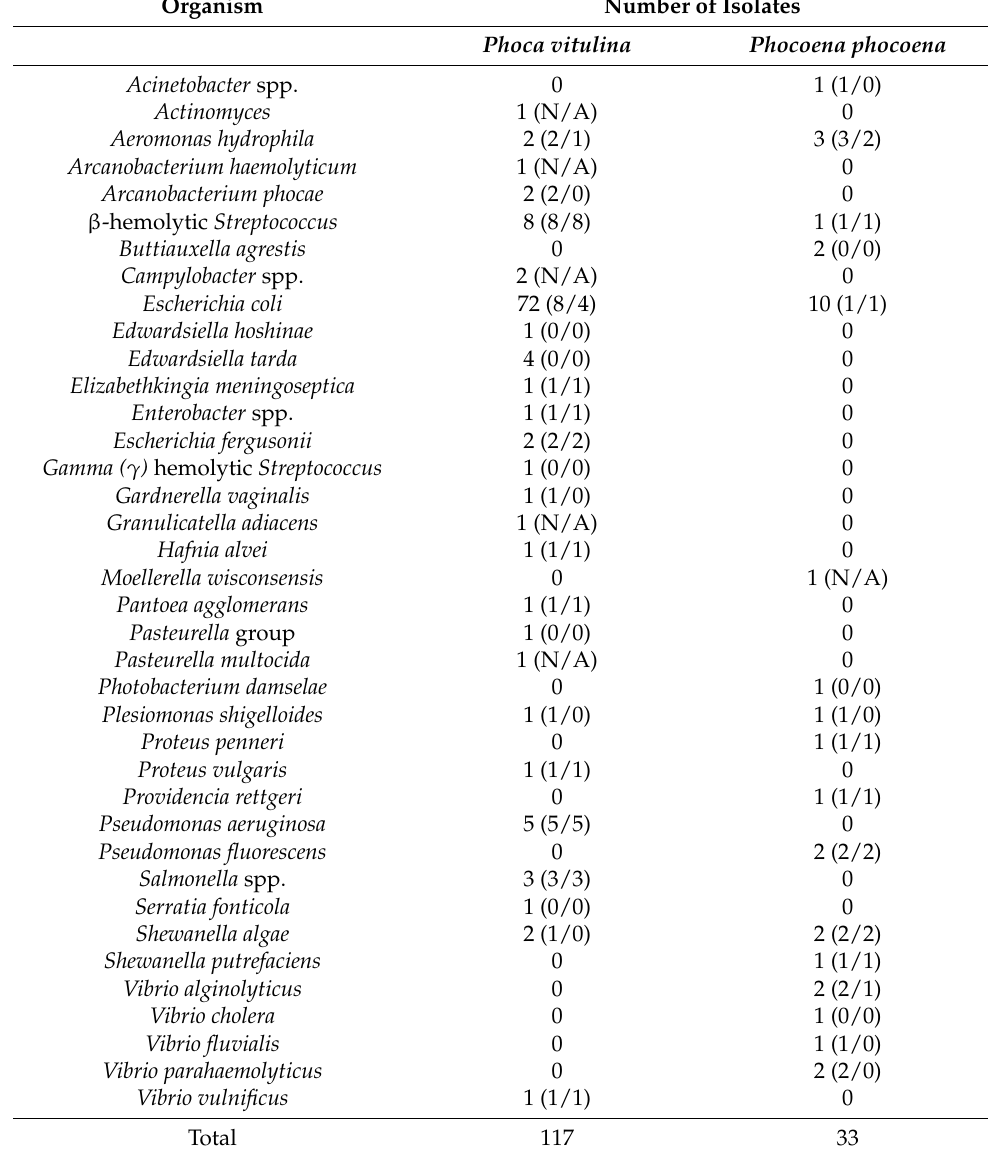
Table 1. Bacterial species identified from various tissues collected from fresh, dead-stranded harbor seals ( Phoca vitulina ) and harbor porpoises ( Phocoena phocoena ) from the Salish Sea, Washington State, USA. Where applicable, the first number in parentheses refers to the number of isolates resistant to at least one antibiotic, followed by number of isolates resistant to more than one antibiotic. N/A = not tested for